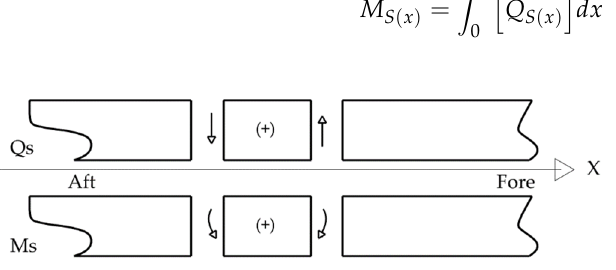
Figure 3. Sign convention for shear forces (Qs(x)) and bending moments (Ms(x)) in still water.